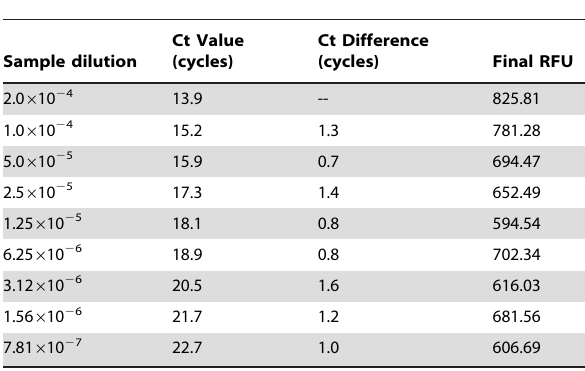
Table 3. Ct values, final intensities and sequencing results from triplicate nested TaqMan Real-Time PCR reactions for packed cell samples from wild `amakihi with presumptive pox lesions.